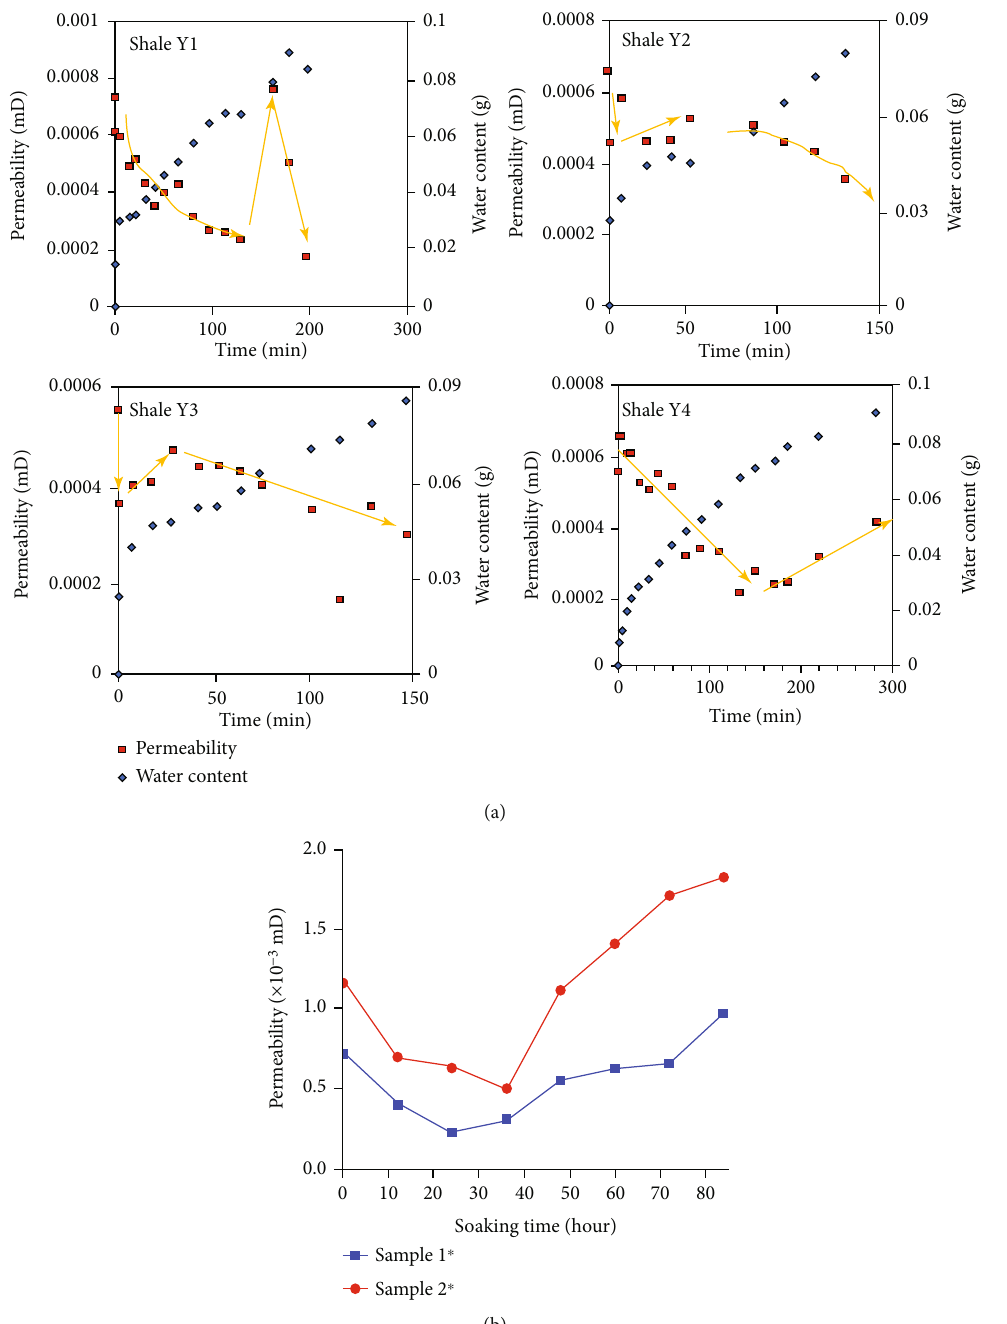
Figure 19: (a) Change of shales ’ permeability in water imbibition tests [24]. (b) Change of shales ’ permeability in water imbibition tests